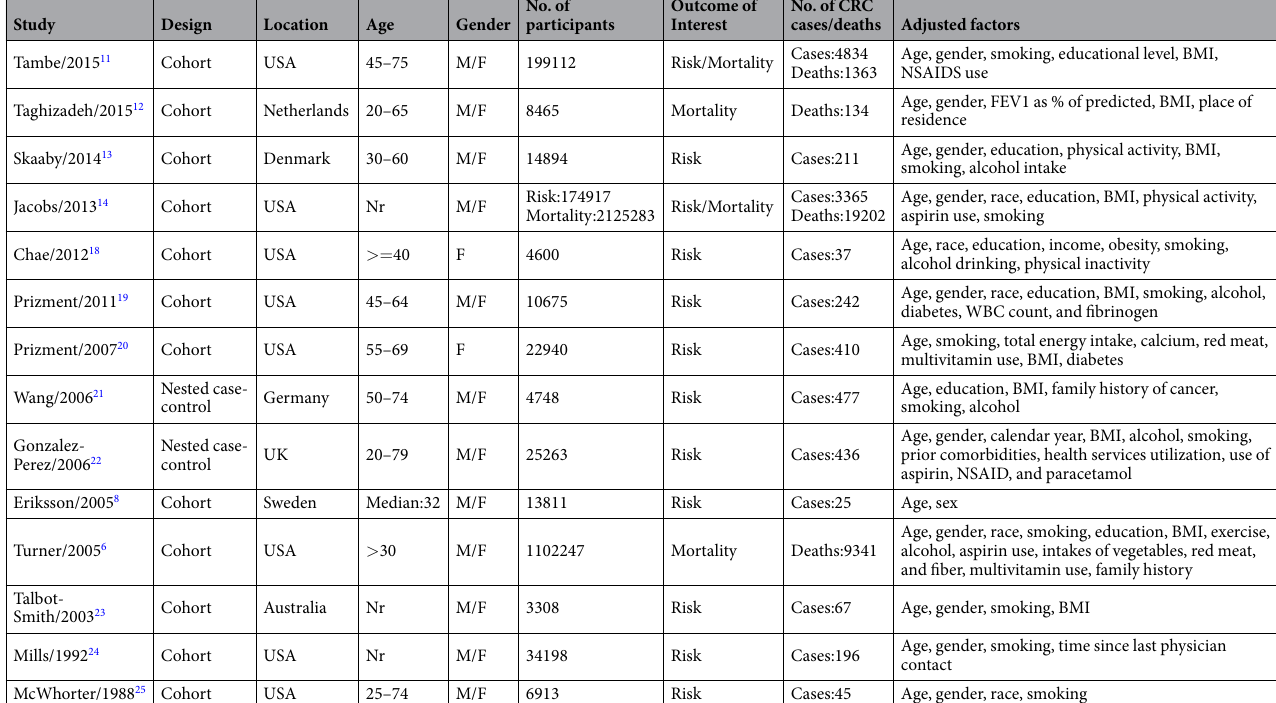
Table 1. Characteristics of the studies included in the meta-analysis. Nr: not reported; BMI: body mass index; NSAIDS: non-steroidal anti-inflammatory drugs.